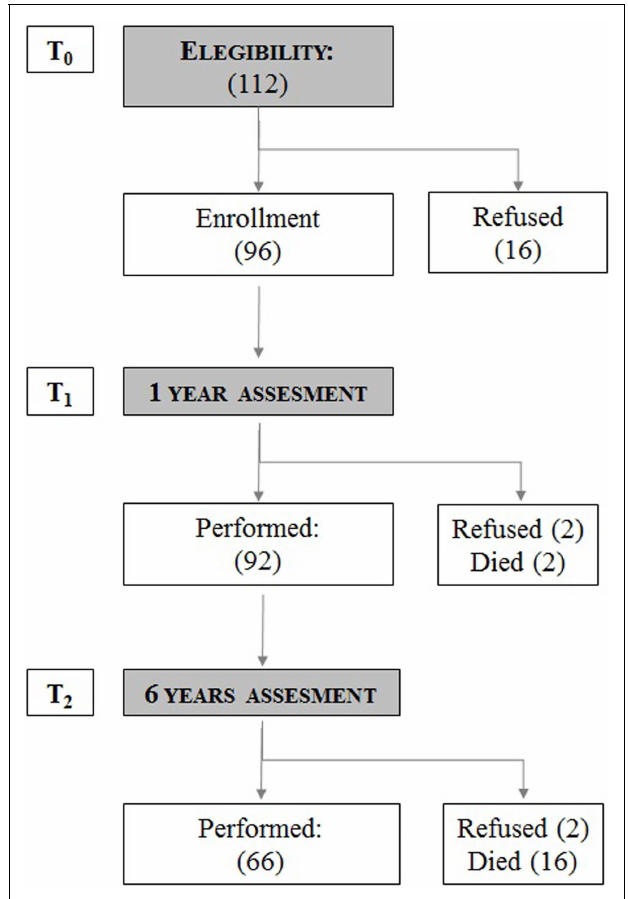
FIGURE 1 | Study flow chart .The number of patients analyzed at baseline (T0), after 1year (T1), and after 6years (T2).The number of patients who refused to continue the study and the number of patients who died during the study time is